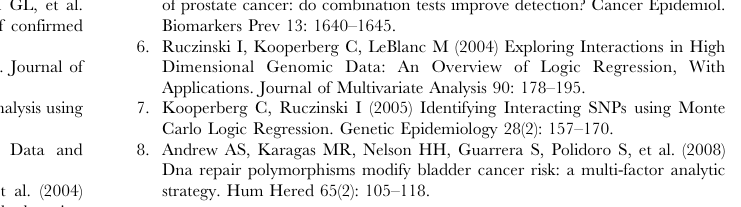
Table S1 One hundred and ninety five genes with the strongest evidence for association with Crohn’s Disease risk, with chromosomal locations, numbers of SNPs, approximate p-values, and Bayes factors. Figure S1 Principal components from the three data- sets: WTCCC, Non-Jewish and Jewish subjects are represented by black circles, green pluses, and blue triangles, respectively. (PDF)